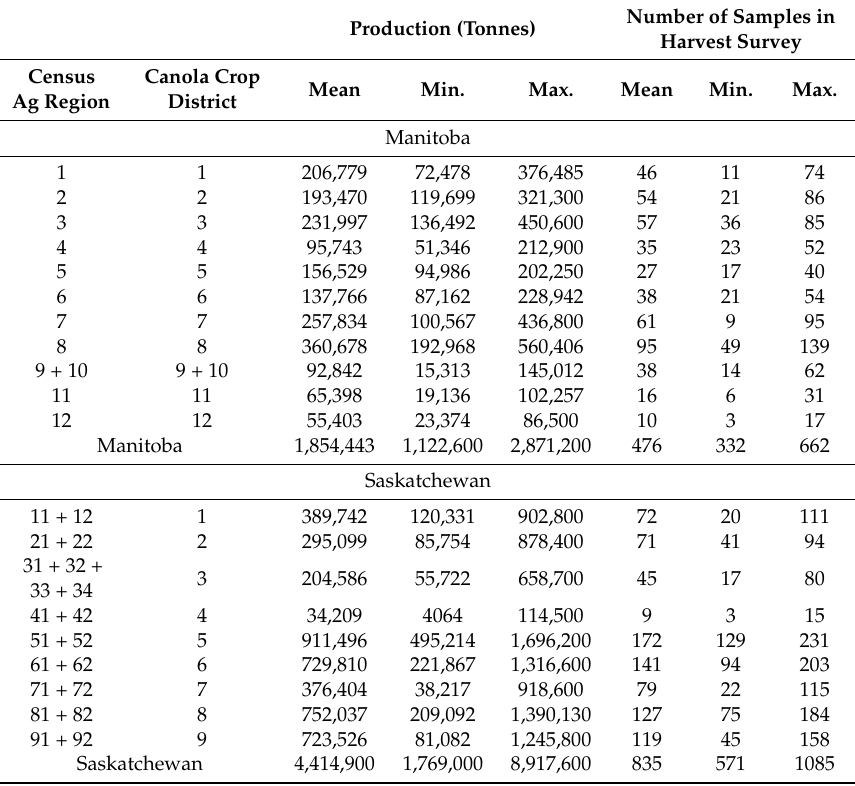
Figure 1. Scheme of the western provinces (Manitoba, Saskatchewan and Alberta) showing each crop district present in the 2013 production survey and the number of samples received for the harvest survey in 2014 for each crop district. Table 2. Crop district summary table—Canola production per crop district (average, minimum and maximum) and number of samples received by the annual harvest survey program (average, minimum and maximum) from 1 August 2000 to 31 July 2014.